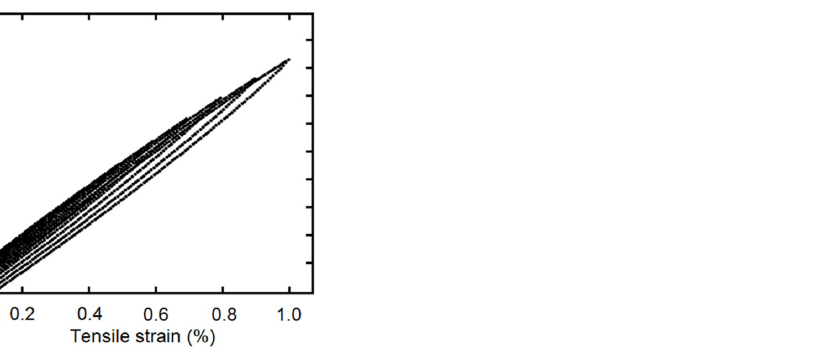
Figure 4. Loading–unloading tensile tests with strain as entrance signal, one specimen with 9 wt%.